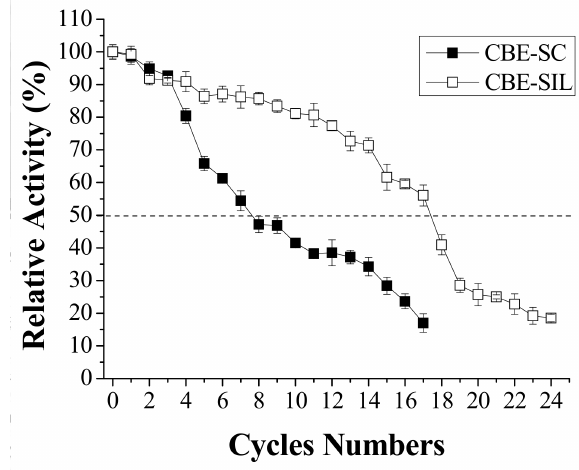
Figure 3. Operational stability of the lipase from Burkholderia cepacia immobilized by covalent binding. Reactional conditions were: 45 ◦ C, pH 3.0, during 10 min and 80